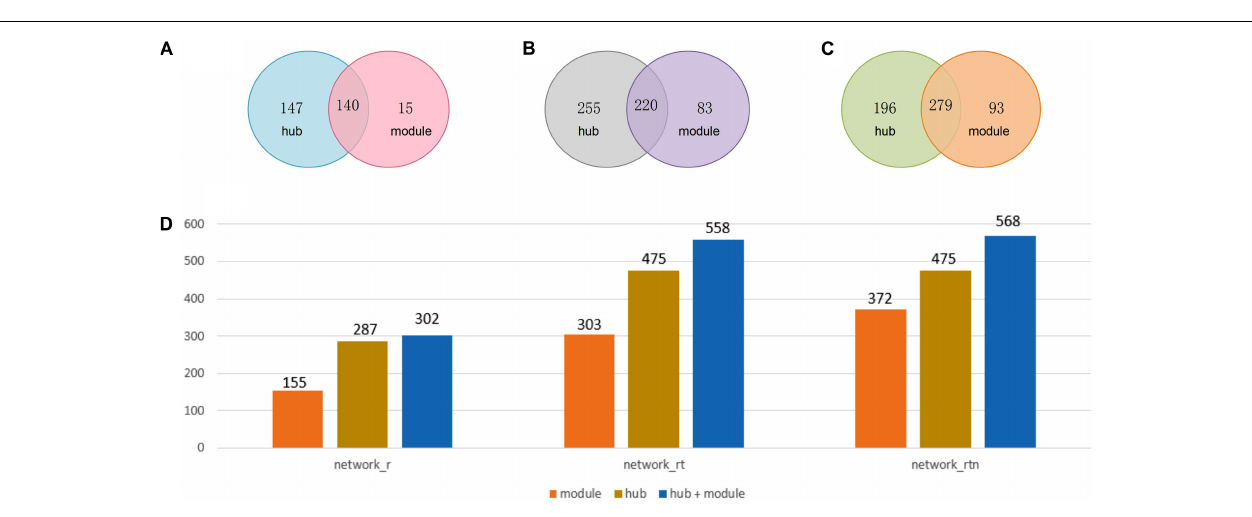
Frontiers in Genetics |